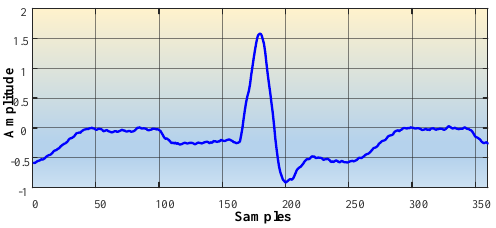
Figure 6. LBBB arrhythmia signal example.